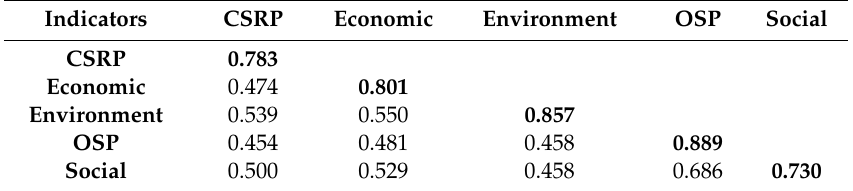
Table 5. Discriminant validity.